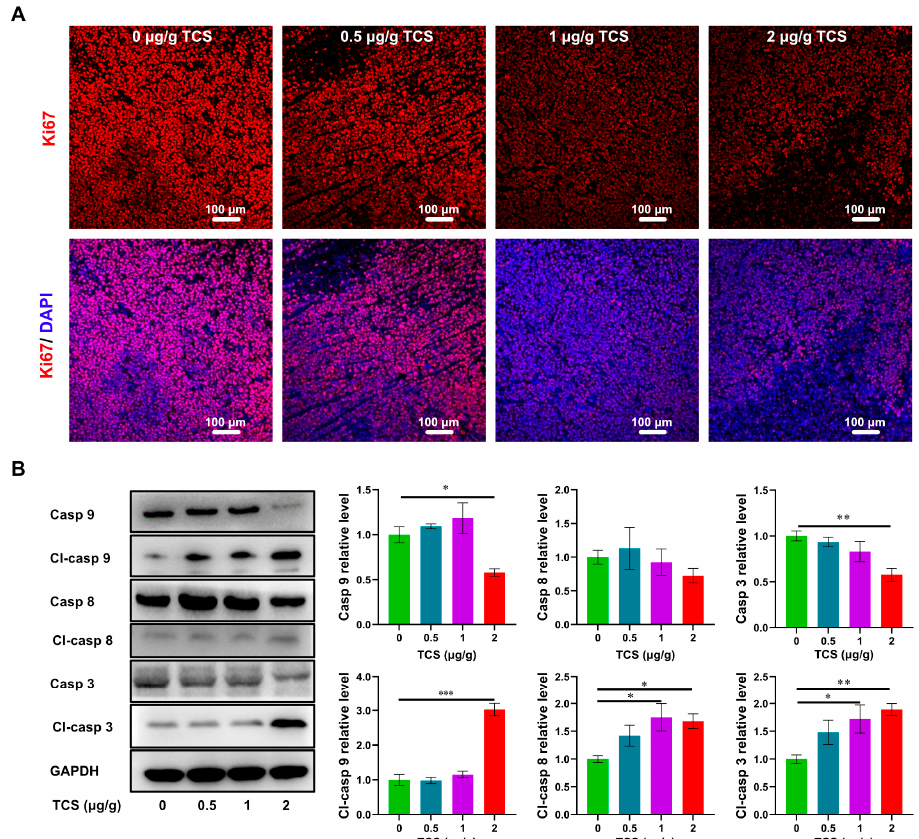
Figure 4. Effects of TCS on proliferation and apoptosis of HCC in vivo. ( A ) Immunofluorescence method detected nuclear proliferation factor Ki67 (Ki67: red, DAPI: blue). Bar = 100 µ m; ( B ) Western blot method detected the protein levels of Caspase 9, Cleaved-caspase 9, Caspase 8, Cleaved-caspase 8, Caspase 3 and Cleaved-caspase 3 in HCC tissues. *, p < 0.05; **, p < 0.01; ***, p < 0.001.